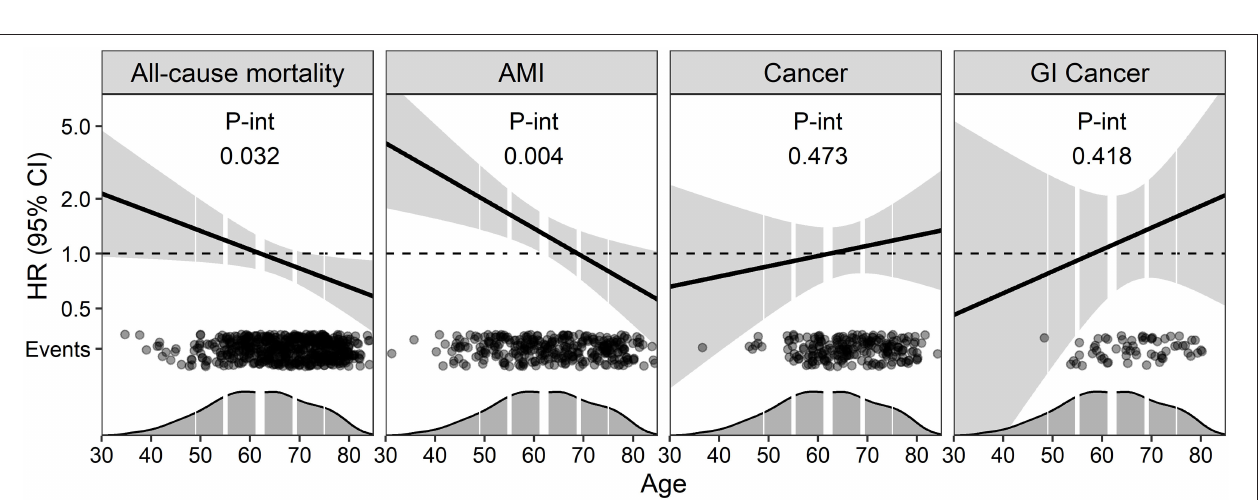
FIGURE 4 | The association between energy-adjusted total meat intake and the risk of clinical outcomes across age. The curves are fitted by including age as an interaction term to Model 1 (adjusted for self-reported energy intake, age, sex, and smoking). The HRs are given per 50 g/1,000 kcal higher intake of meat, and light gray areas around the central line represent 95% CIs of the hazard ratios. Dark gray areas at the x-axis are density plots of age, and the vertical white lines indicate the 10th, 25th, 50th (bold line), 75th, and 90th percentiles. The black dots indicate events across age. AMI, Acute myocardial infarction; GI, Gastrointestinal.